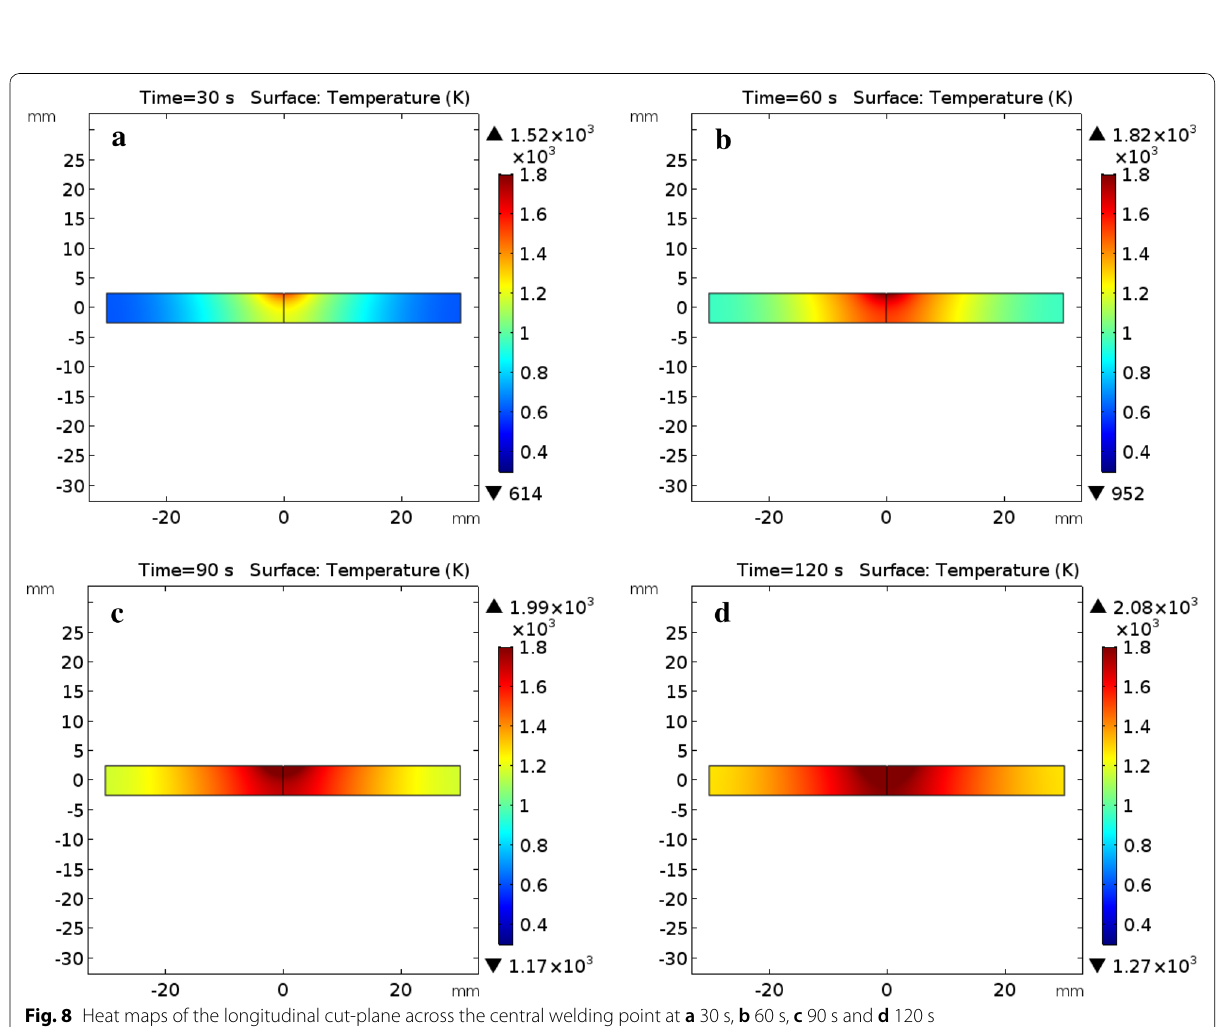
Fig. 8 Heat maps of the longitudinal cut-plane across the central welding point at a 30 s, b 60 s, c 90 s and d 120 s